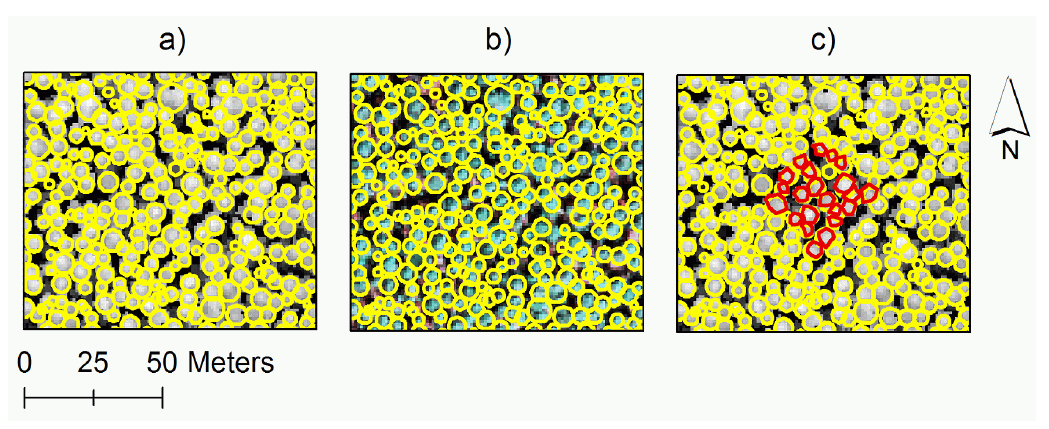
Figure 3. Automatically delineated pines (yellow circles) with (a) nDSM, (b) CIR orthophoto and (c) crowns measured in the field (red